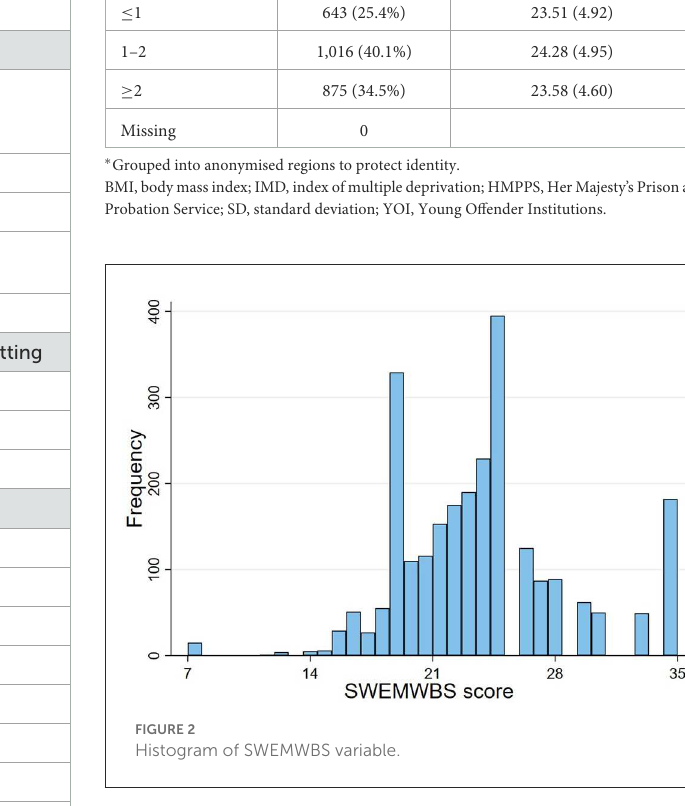
and median (24.11). However, there were four total SWEMWBS scores of elevated frequency. It was ascertained that these totals related to people who had marked all SWEMWBS questions with the same answer, either 1, 2, 3, or 5. A score of ≤ 17 is highly correlated with mental illness (24)- − 4.4% ( n = 111) of participants scored ≤ 17. The HSE standardised mean SWEMWBS score was 23.57. The prison staff sample had a statistically significantly higher mean SWEMWBS score (23.84) than the standardised HSE mean ( p = 0.004; 95% CI 23.66, 24.03). However, this was less than the previously defined meaningfully important difference of one point. In univariate linear regression analysis, SWEMWBS score was significantly associated with age, sex, ethnicity, smoking status, occupation, HMPPS region, prisoner functional category, and prisoner/staff ratio. The final multivariate linear regression model was adjusted for age category, sex, ethnicity, smoking status, presence of comorbidities, occupation, and HMPPS region (Table 3). Significantly higher SWEMWBS scores were associated with older age, male sex, Black/Black British ethnicity and staff occupation (specifically health staff compared to prison service staff). Additionally, HMPPS regions R5 and R11 were significantly associated with higher wellbeing as compared to R1 at